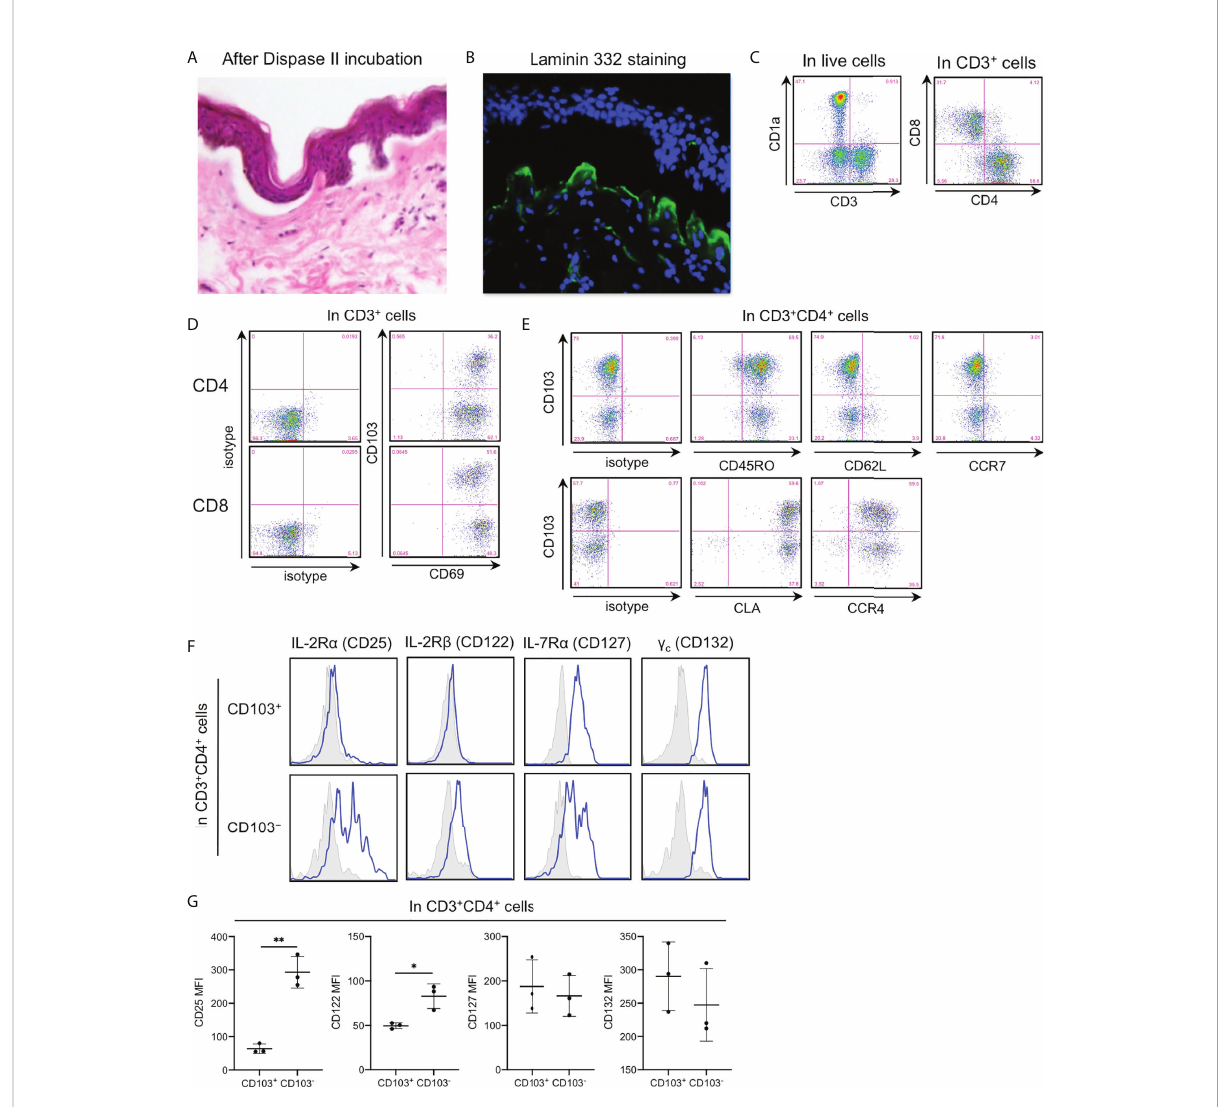
FIGURE 1 Higher IL-2R a (CD25) and IL-2R b expressions in the epidermal CD4 + CD103 − cells. (A) Hematoxylin – eosin staining of normal skin incubated with Dispase II overnight at 4°C. (B) Laminin 332 staining in (A) . (C-F) Representative expression of indicated antigens in indicated cell populations. (G) An MFI summary of (F) . All the experiments were conducted using at least three different samples. Comparisons between groups were evaluated using Student ’ s t -test (one-tailed); * p < 0.05 and ** p <